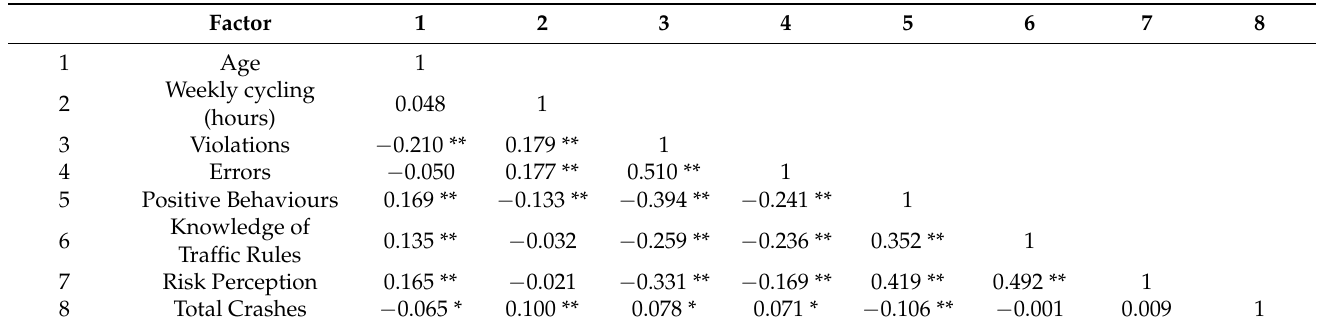
Table 3. Bivariate (Pearson) Correlations.